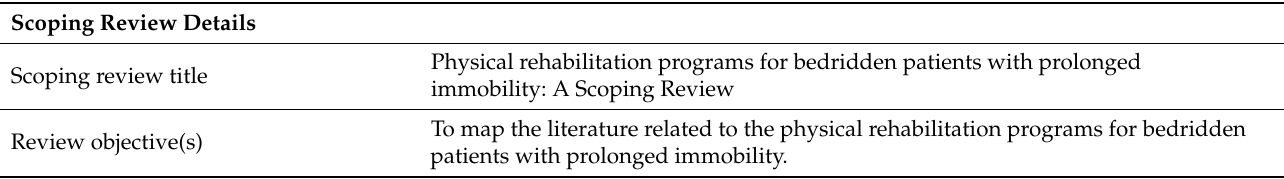
Table 2. Data extraction